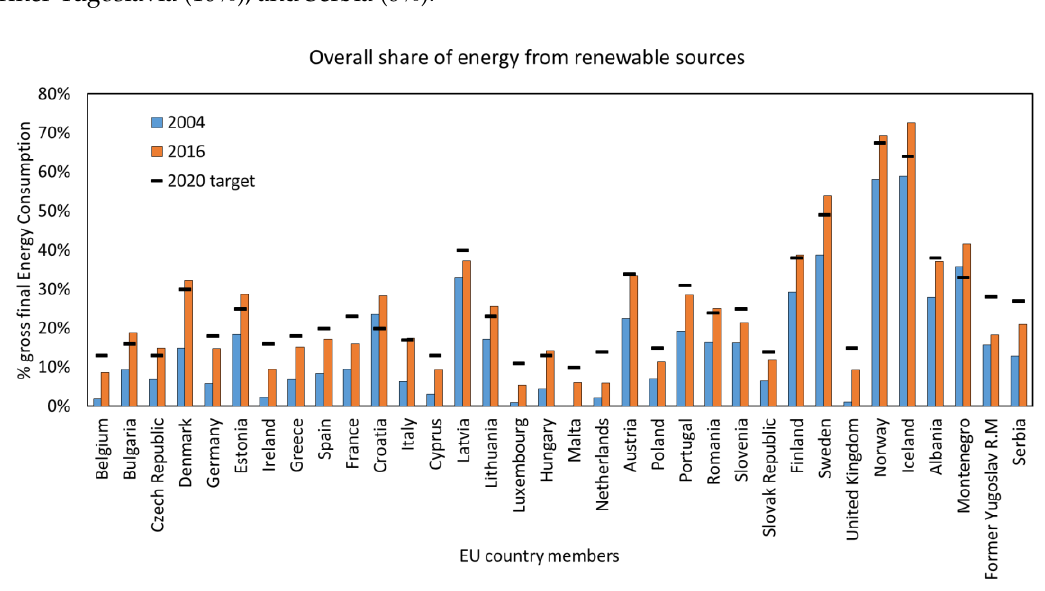
Figure 3. Overall share of energy from renewable sources in European countries, with the percentage of share in 2004 and 2016, and the target for 2020. Based on data provided by Eurostat